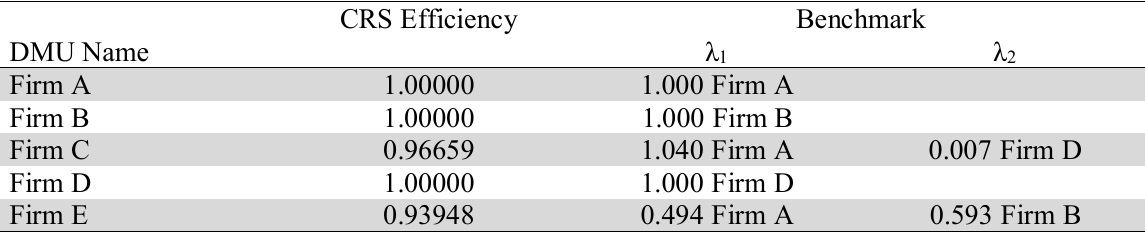
Benchmarks for construction